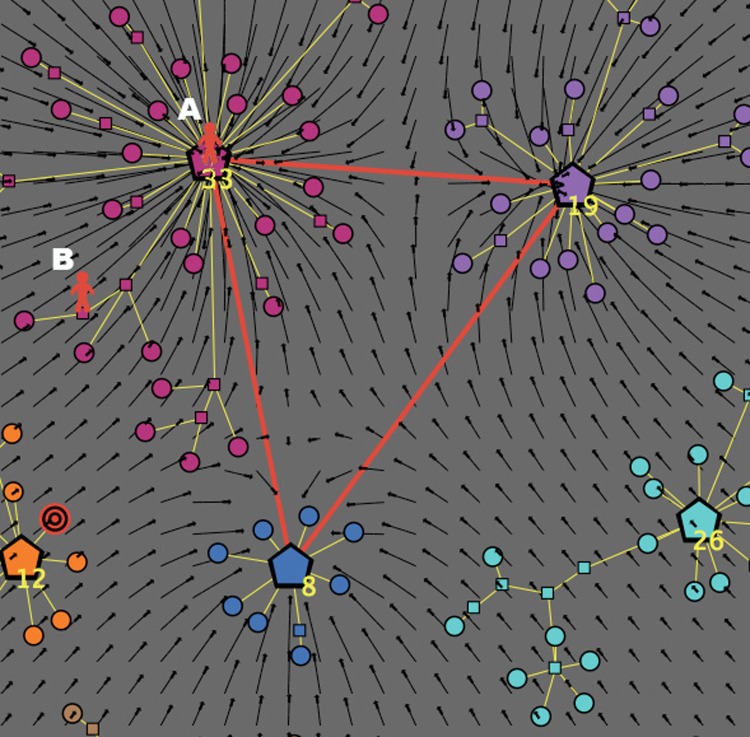
Dynamical rules determining the buyer’s next move: the case of low awareness.The consumer is highly influenced by the attraction field induced by her active clusters, without consideration for the target.